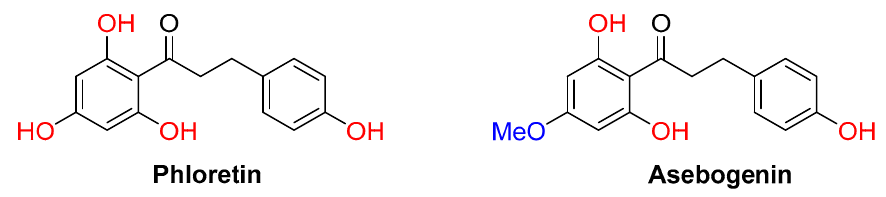
Figure 1. Structures of phloretin and asebogenin.